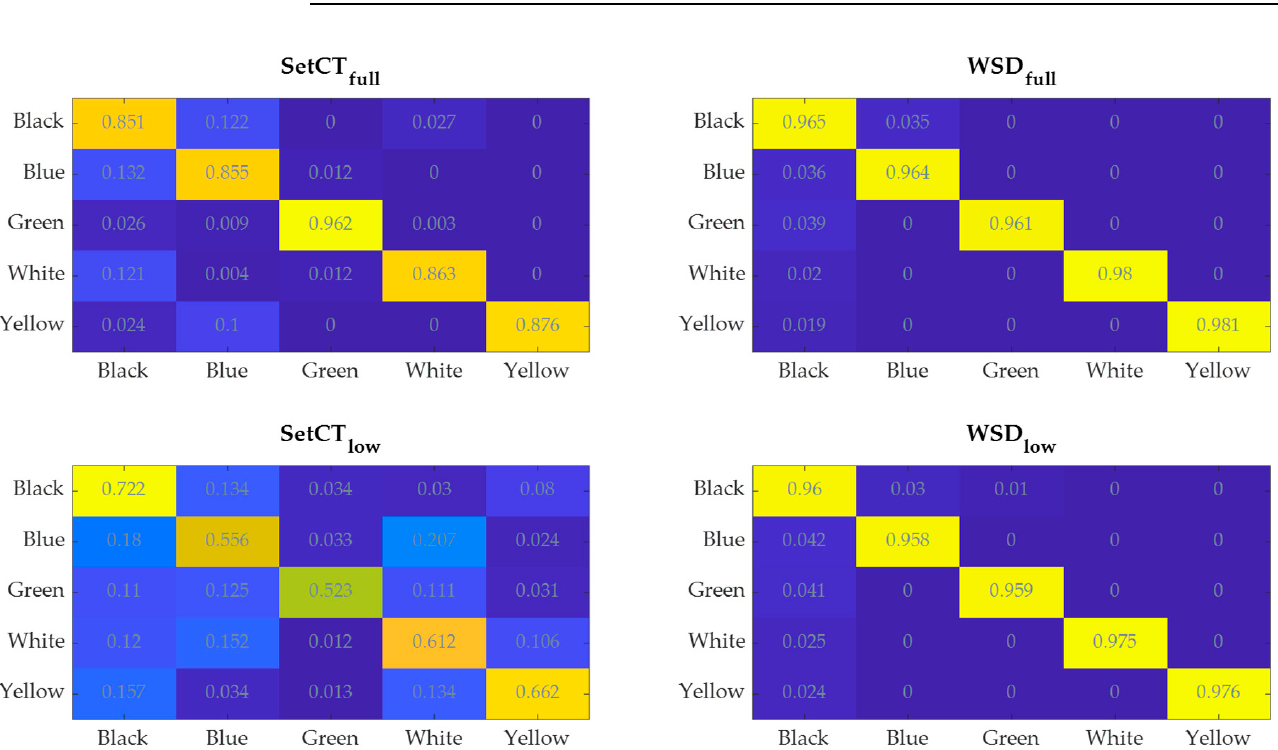
Figure 14. Confusion matrix of SetCT high , SetCT low WSD high, and WSD low.